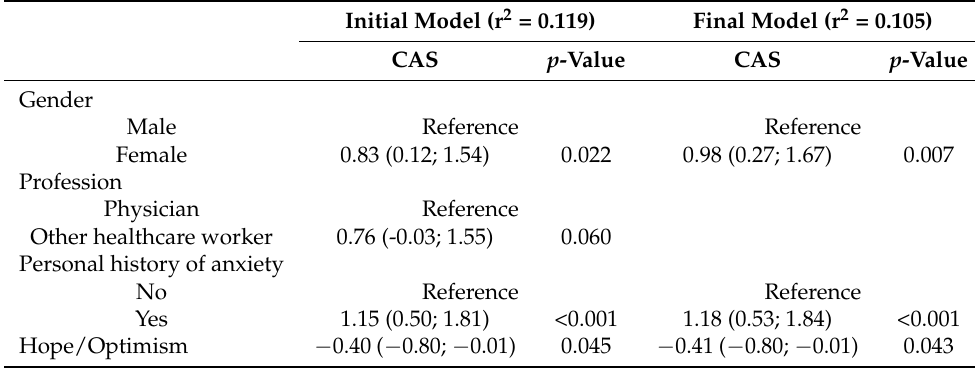
Table 5. Multivariable Model—Coronavirus Anxiety Scale